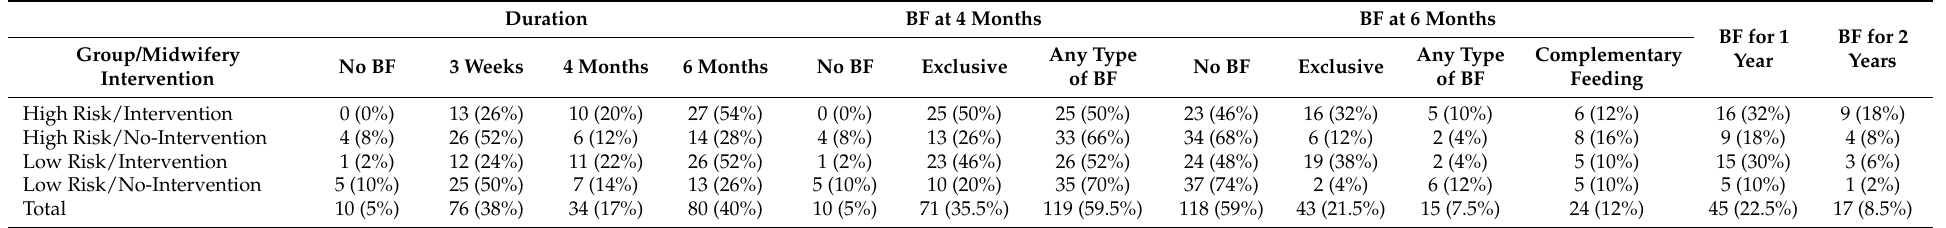
Table 3. Number of cases and percentage of breastfeeding duration in the control group and experimental group in each evaluation period. Each cell shows: the number of cases and the percentage within the group (row percentage). BF: